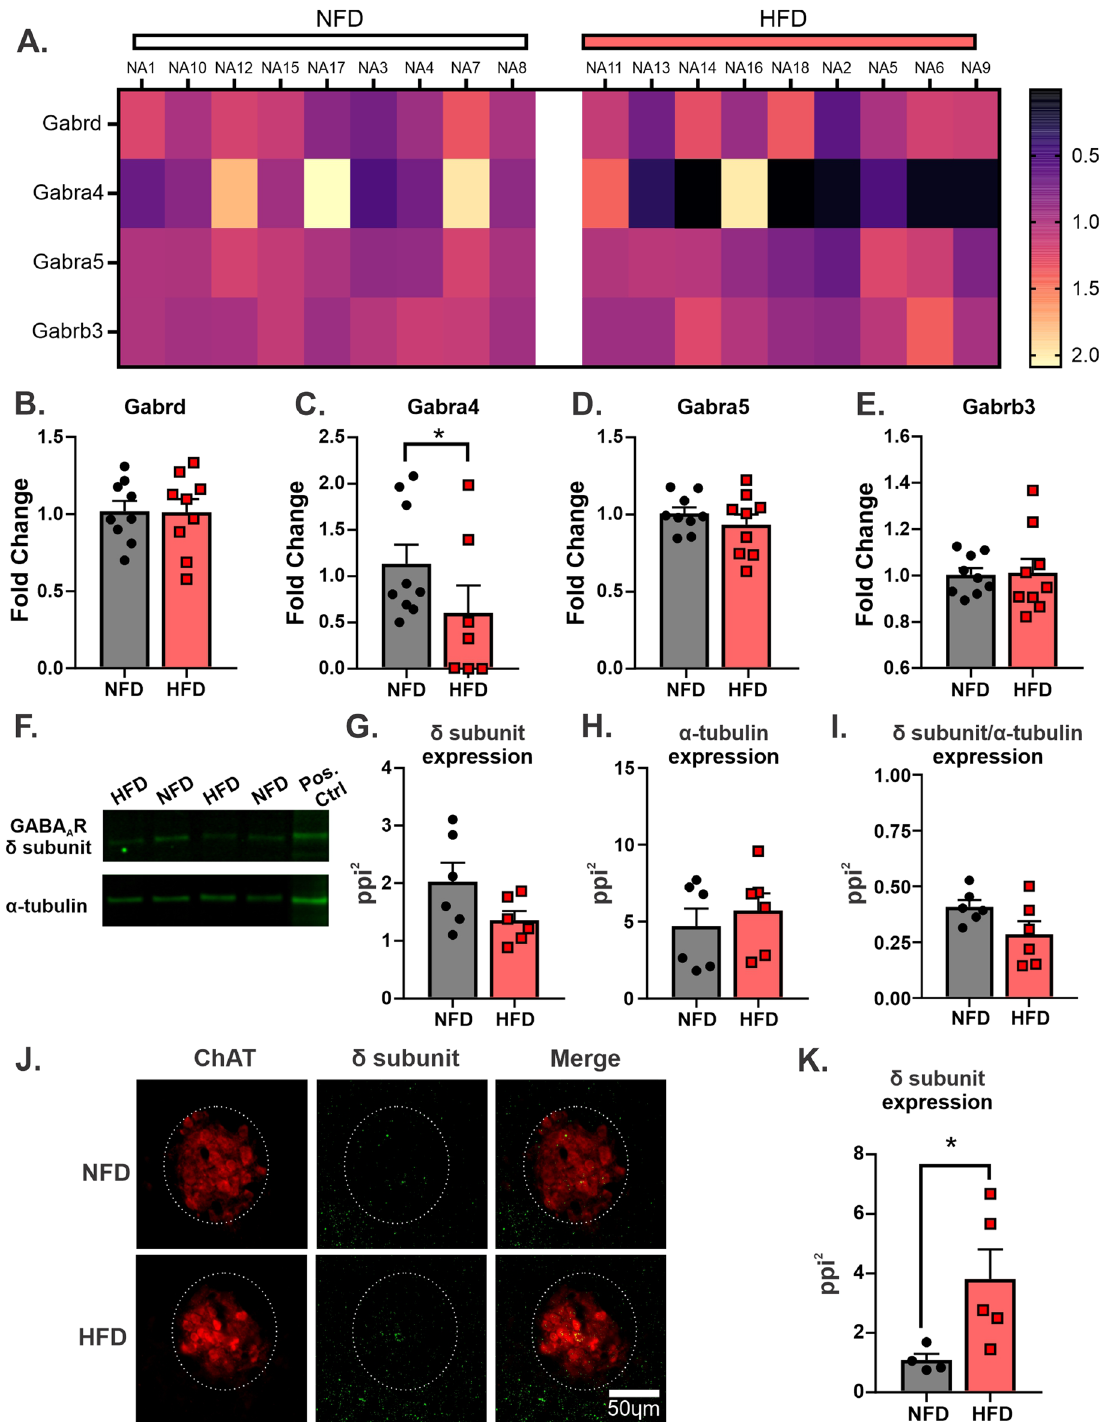
Figure 3. GABA A (δ) receptor surface expression was increased after 15 days of HFD. Heat map of GABA A R subunits mRNA level in NA samples on Day 15 of diet (NFD: n = 9; HFD: n = 9) ( A ). Each column represents a single individual sample, both right and left NA are pooled. Mean mRNA levels of Gabrd ( B ), Gabra4 ( C ), Gabra5 ( D ), and Gabra3 ( E ) subunits. Gabra4 expression was significantly decrease after 15 Day of HFD compared to NFD. Representative western blot ( F ). No changes in GABA A (δ)R ( G ), α-tubulin loading control ( H ), and normalized GABA A (δ)R protein levels between HFD (n = 6 from 12 mice) and NFD (n = 6 from 12 mice) on Day 15 ( I ). Original western blot is presented in Supplementary Fig. 1. Representative immunohistochemical images co-strained for ChAT (red) and GABA A (δ)R (green) in NA on Day 15 of diet ( J ). GABA A (δ)R surface expression in ChAT + neurons within NA was increased after HFD (n = 5) compared to NFD (n = 4) ( K ). * denotes significant difference between